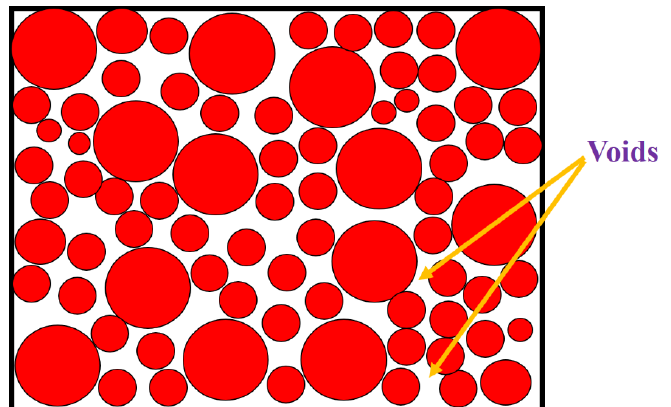
Figure 1. Powder bed schematic with voids.